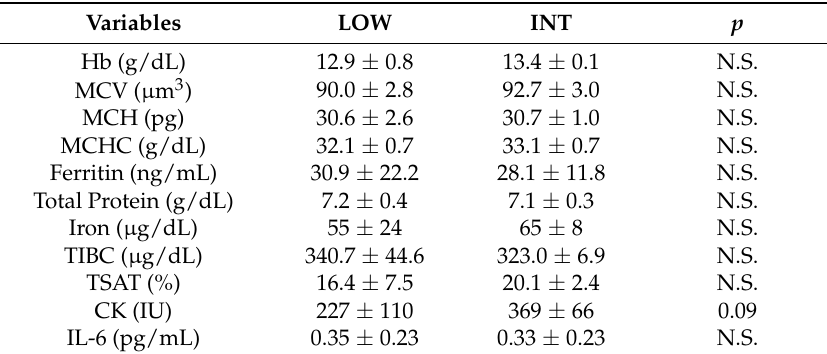
Table 2. Comparisons of blood variables over experiment